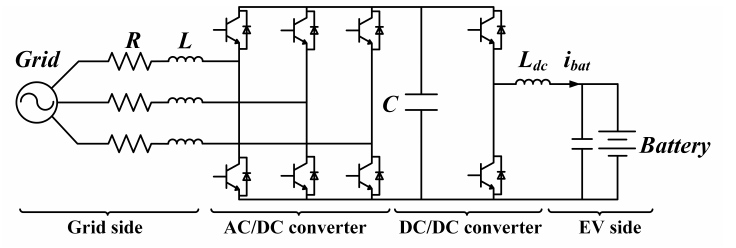
Figure 4. Three-phase off-board